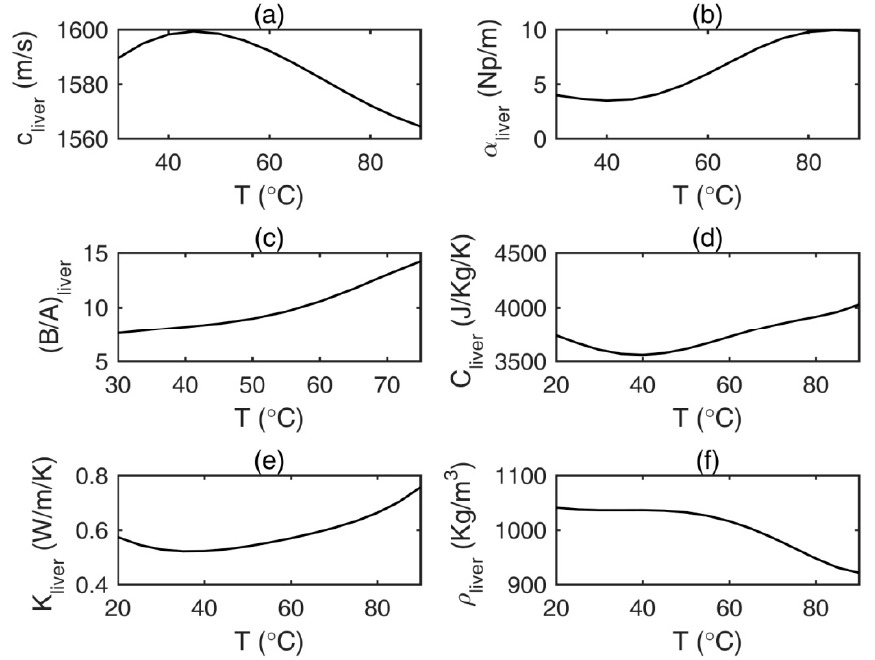
Figure 1. Temperature-dependent tissue properties in liver tissue.